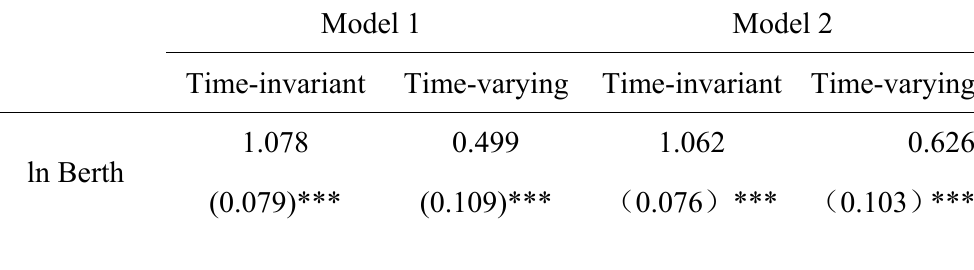
Table 5. Results of the Stochastic Frontier